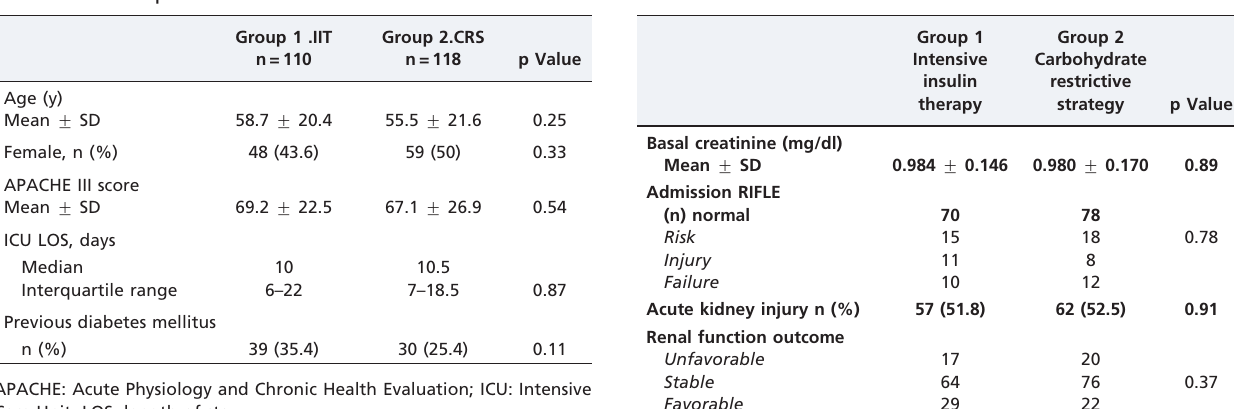
Table 3 - Renal outcomes.